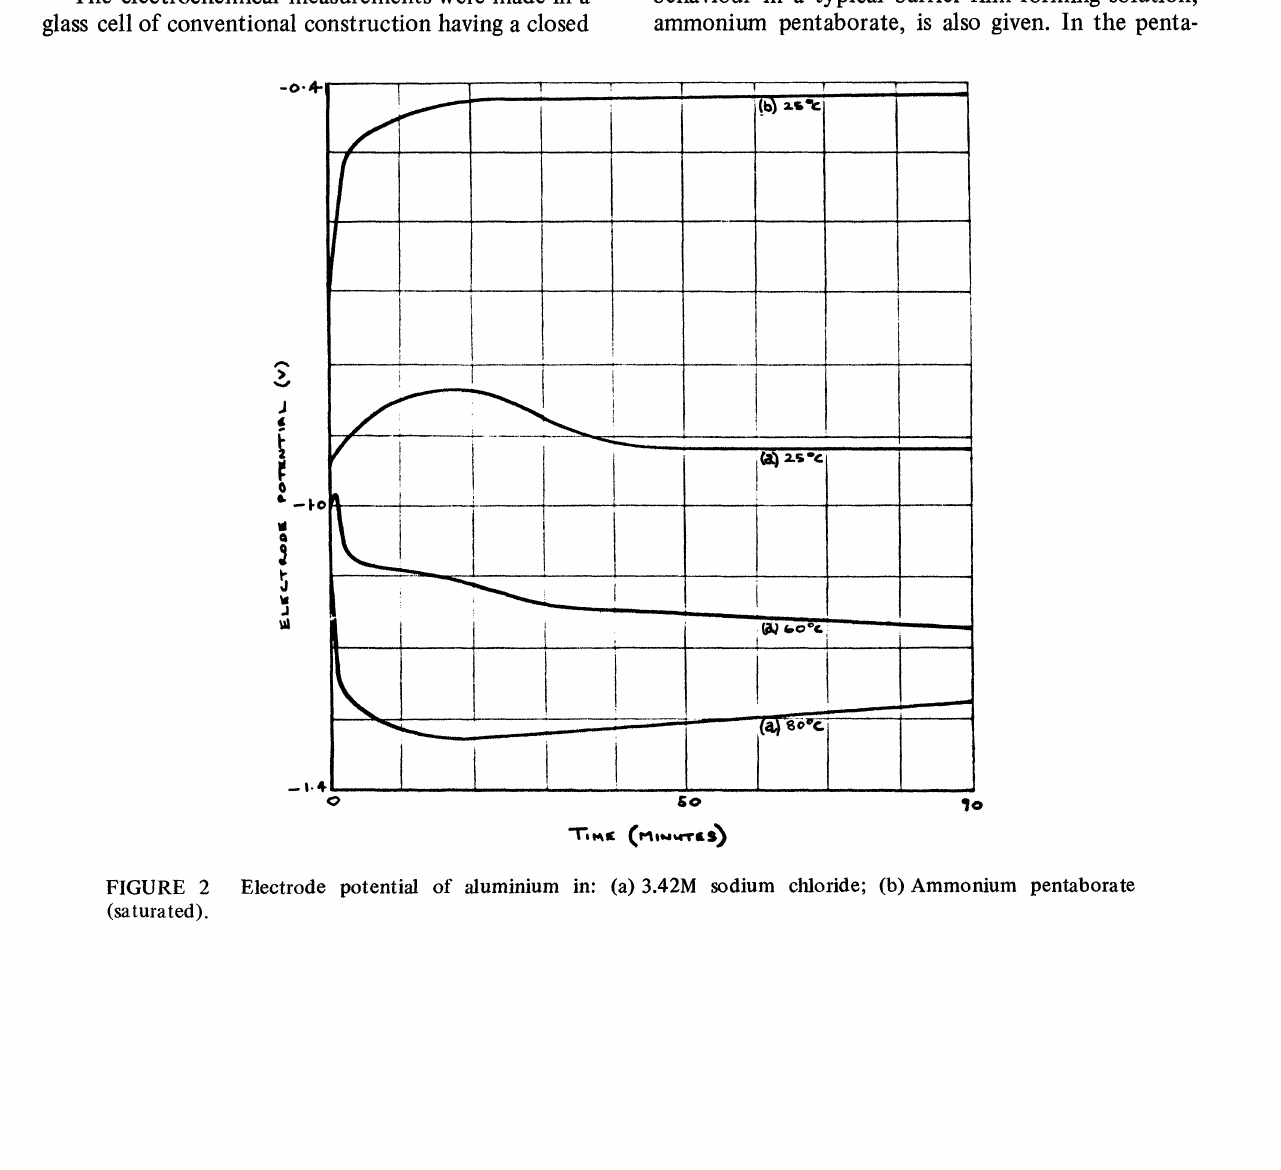
Electrode potential of aluminium in: (a)3.42M sodium chloride; (b) Ammonium pentaborate